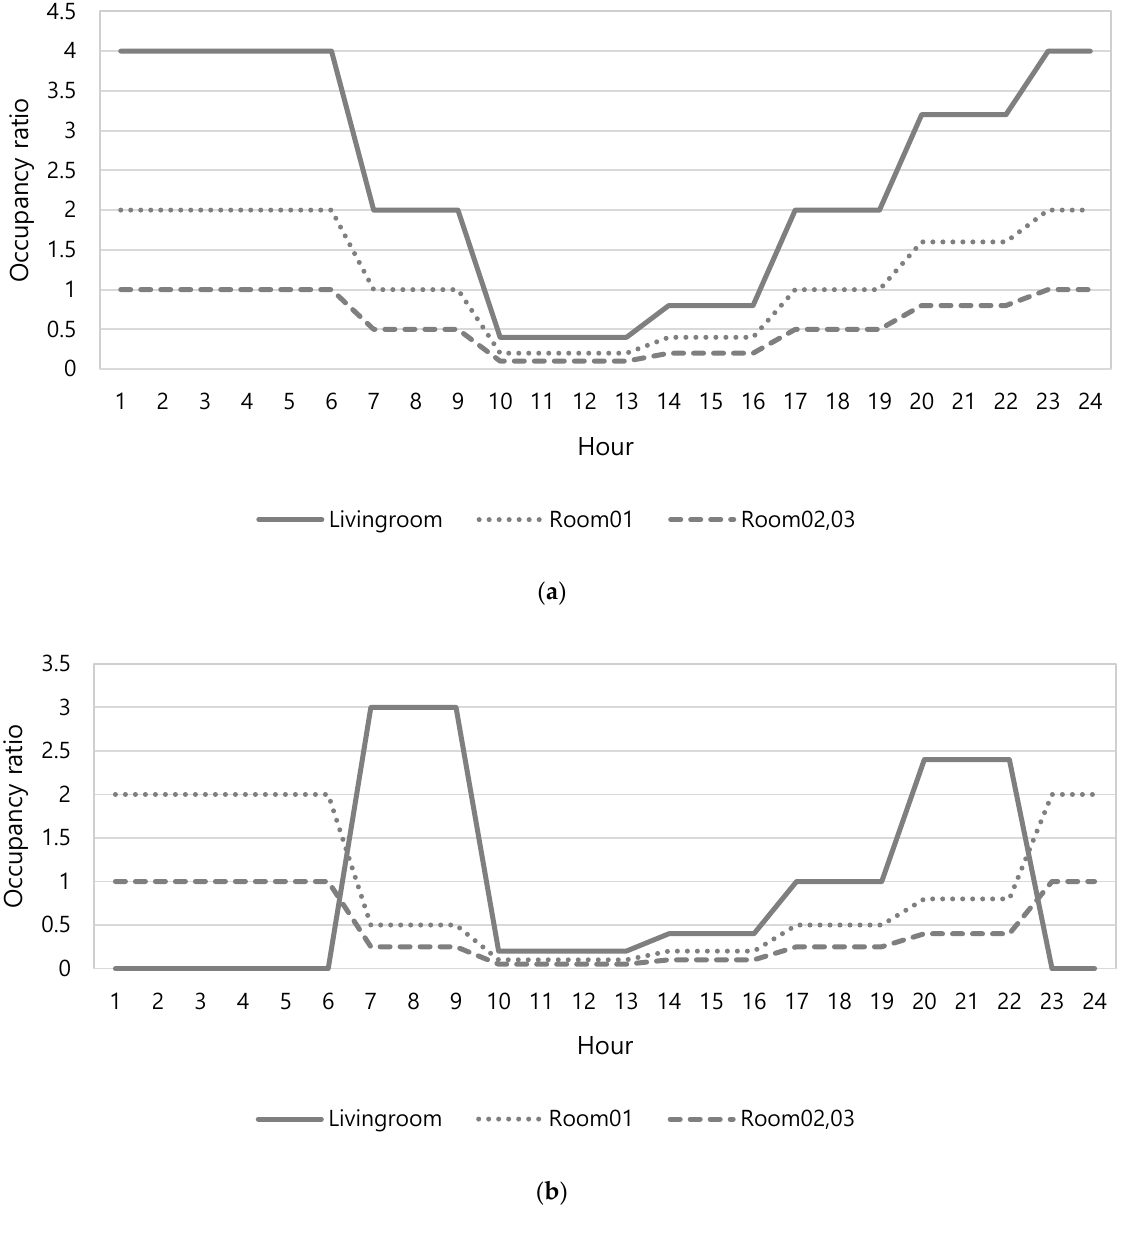
Figure 5. ( a ) Occupancy schedule for conventional HVAC system. ( b ) Occupancy schedule for decentralized ventilation.